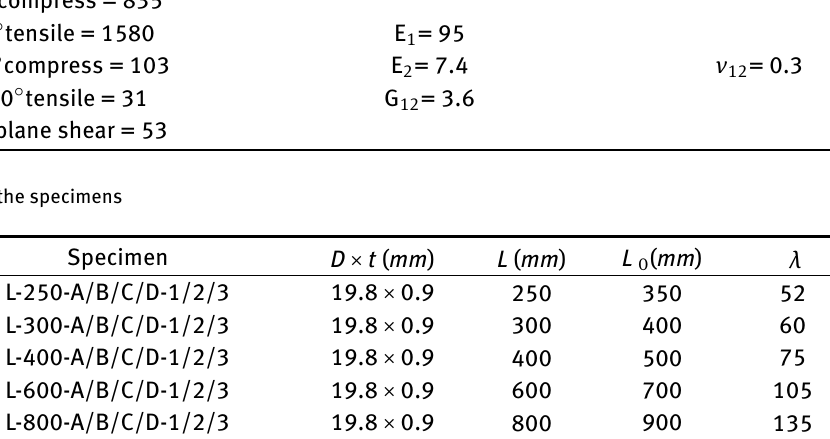
Table 1: Elastic constant of the T700 / YPH-307 systems Strength (MPa)